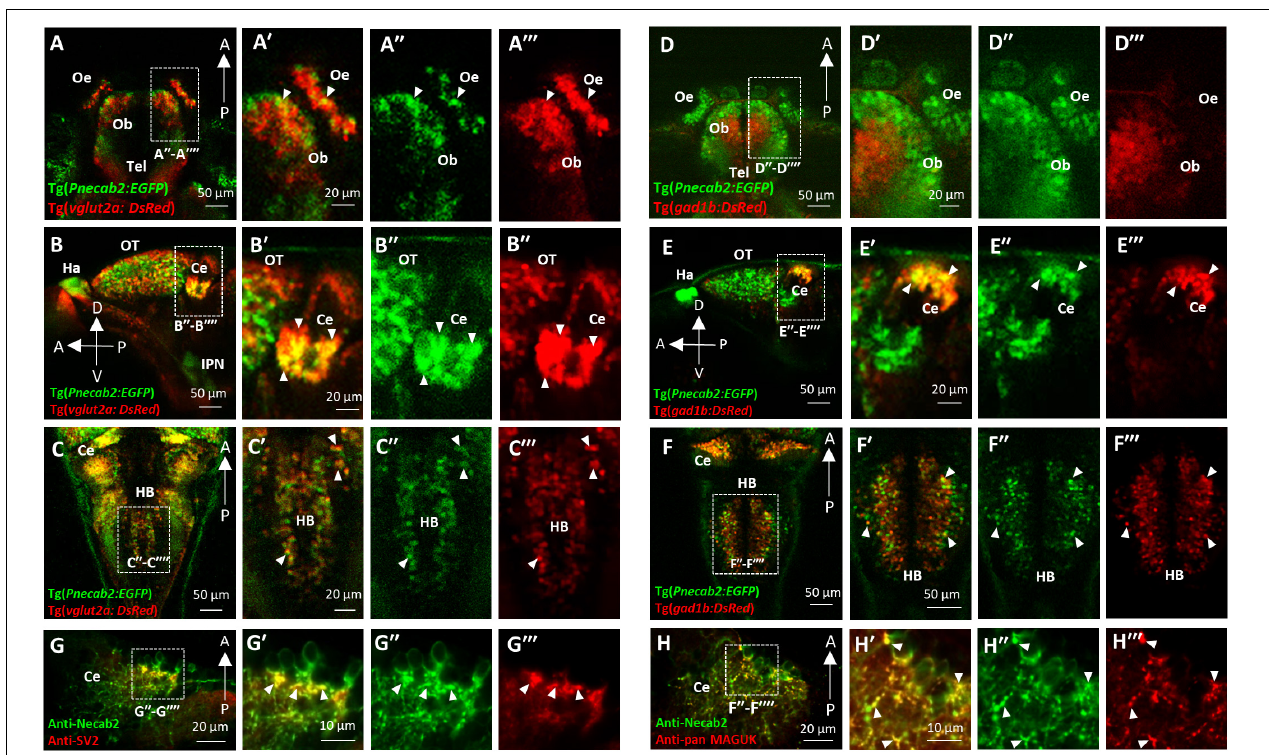
FIGURE 2 | Necab2 is expressed in subsets of glutamatergic and GABAergic neurons. (A–A (cid:48)(cid:48)(cid:48) ) Confocal live imaging of the transgenic fish Tg( Pnecab2:EGFP ) crossed with Tg( vglut2a:DsRed ) at 5 dpf. Necab2 was expressed in subsets of glutamatergic neurons in the telencephalon, olfactory bulb, and olfactory epithelium (arrowheads, dorsal views). Scale bar = 50 µ m (A) . The region in the dashed white box (A) was shown at higher magnification on the right (A (cid:48) –A (cid:48)(cid:48)(cid:48) ) . Scale bar = 20 µ m. (B–B (cid:48)(cid:48)(cid:48) ) . Necab2 was expressed in subsets of glutamatergic neurons in the optic tectum and cerebellum (arrowheads, lateral views). Scale bar = 50 µ m (B) . The region in the dashed white box (B) was shown at higher magnification on the right (B (cid:48) –B (cid:48)(cid:48)(cid:48) ) . Scale bar = 20 µ m. (C–C (cid:48)(cid:48)(cid:48) ) Necab2 was expressed in subsets of glutamatergic neurons in the hindbrain (arrowheads, dorsal views). Scale bar = 50 µ m (C (cid:48) ) . The region in the dashed white box (C) was shown at higher magnification on the right (C (cid:48) –C (cid:48)(cid:48)(cid:48) ) . Scale bar = 20 µ m. (D–D (cid:48)(cid:48)(cid:48) ) Confocal live imaging of the transgenic fish Tg( Pnecab2:EGFP ) crossed with Tg( gad1b:DsRed ) at 5 dpf. The Necab2-expressing neurons rarely overlapped with the gad1b-positive neurons in the telencephalon, olfactory bulb, or olfactory epithelium (arrowheads, dorsal views). Scale bar = 50 µ m (D) . The region in the dashed white box (D) was shown at higher magnification on the right (D (cid:48) –D (cid:48)(cid:48)(cid:48) ) . Scale bar = 20 µ m. (E–E (cid:48)(cid:48)(cid:48) ) Necab2-expressing neurons strongly overlapped with gad1b-positive neurons in the cerebellum (arrowheads, lateral views). Scale bar = 50 µ m (E) . The region in the dashed white box (E) was shown at higher magnification on the right (E (cid:48) –E (cid:48)(cid:48)(cid:48)(cid:48) ) . Scale bar = 20 µ m. (F–F (cid:48)(cid:48)(cid:48) ) Necab2-expressing neurons overlapped with gad1b-positive neurons in the hindbrain (arrowheads, dorsal views). Scale bar = 50 µ m (F) . The region in the dashed white box (F) was shown at higher magnification on the right (F (cid:48) –F (cid:48)(cid:48)(cid:48) ) . Scale bar = 50 µ m. (G–G (cid:48)(cid:48)(cid:48) ) Co-immunofluorescent staining of the anti-Necab2 with anti-SV2 in 7 dpf larvae showed that Necab2 was enriched in the pre-synaptic structures (arrowheads). Scale bar = 20 µ m (G) . The region in the dashed white box (G) is shown at higher magnification on the right (G (cid:48) –G (cid:48)(cid:48)(cid:48) ) . Scale bar = 10 µ m. (H–H (cid:48)(cid:48)(cid:48) ) Co-immunofluorescent staining of anti-Necab2 with anti-pan MAGUK in the 7 dpf larvae showed that Necab2 was enriched in the postsynaptic structures (arrowheads). Scale bar = 20 µ m (H) . The region in the dashed white box (H) was shown at higher magnification on the right (H (cid:48) –H (cid:48)(cid:48)(cid:48) ) . Scale bar = 10 µ m. dpf, day post-fertilization; Tel, telencephalon; Ce, cerebellum; Hb, habenula; OT, optic tectum; IPN, interpeduncular nucleus.